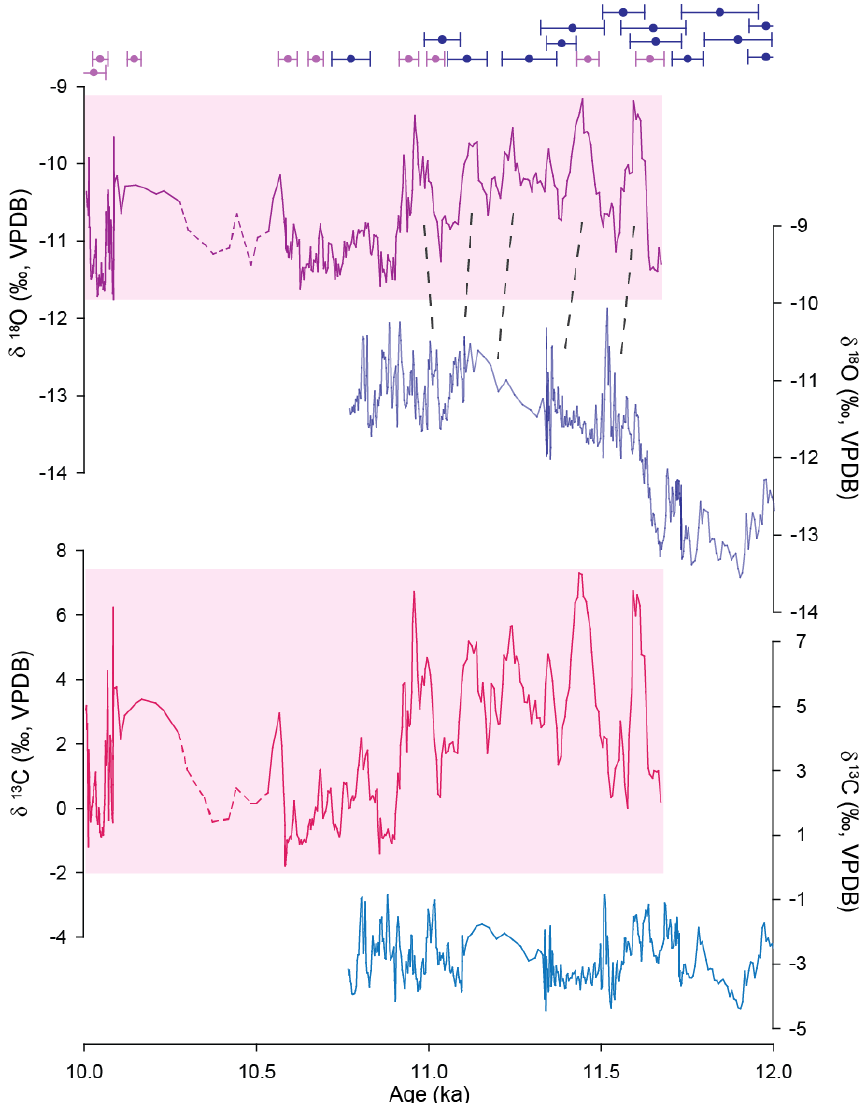
Figure 5. Stable isotope variability of LAS 72 (pink) and LAS 19 (blue) between 12 and 10ka. Dashed lines in the stable isotope time series of LAS 72 represent the period characterized by slow growth rate. Dashed tie lines indicate similarities between the δ 18 O variability of the two flowstones. Note that LAS 72 is comprised of aragonite as indicated by the pink rectangle, while LAS 19 is a calcitic